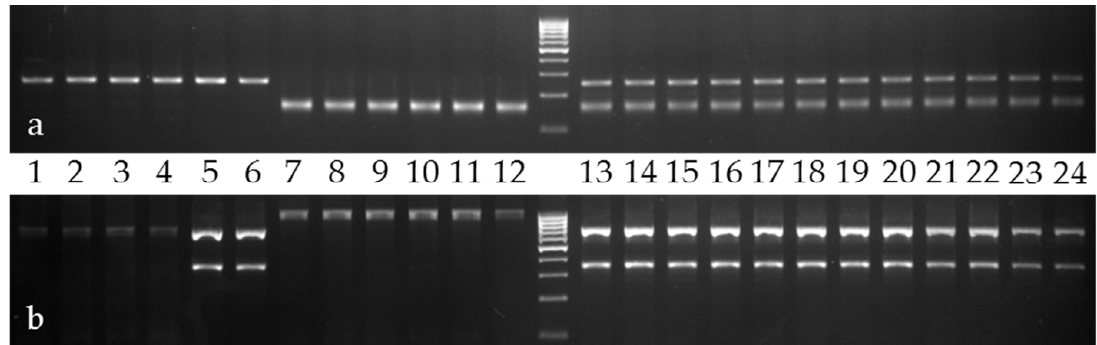
Figure 1. The results of win3 ( a ) and trn L / trn F ( b ) marker experiments with P. deltoides ssp. monilifera (1–4), P. deltoides ssp. deltoides (5,6), P. nigra (7–11), P.nigra var. italica (12) and P. × canadensis (13–24) samples. The marker of molecular weight has a 100 bp step. The numbers of samples correspond to